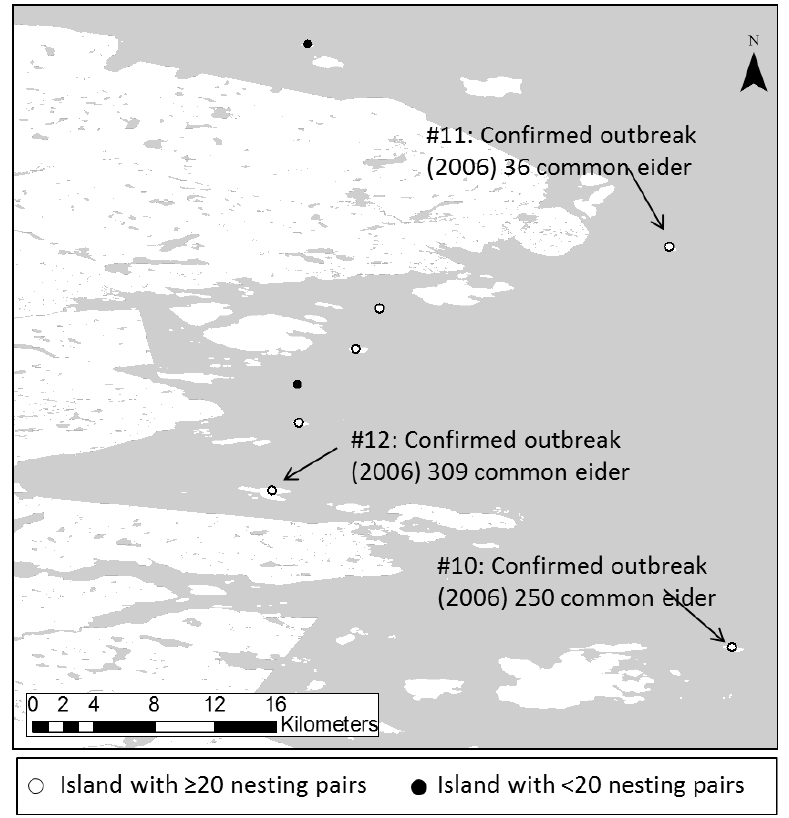
Figure A1.4. Survey zone 4: Joy Bay, Central Ungava